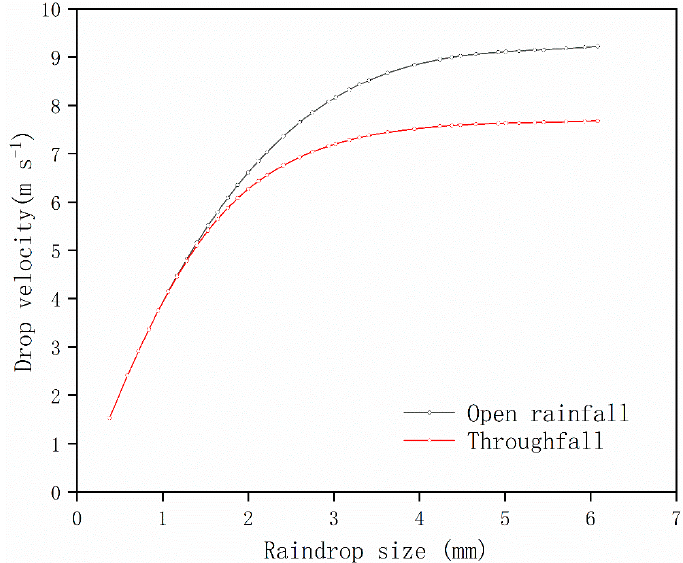
Figure 7. The relationship of raindrop velocity to diameter of total observed drops.